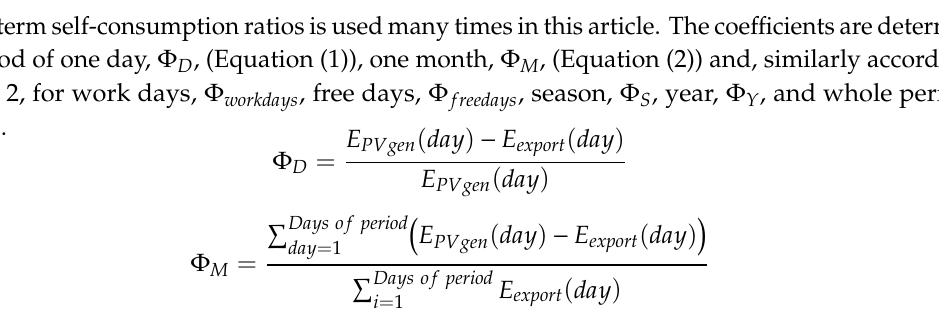
Figure 13. Relative self-consumption as a function of the daily PV generation, indicating the months of the year. Subsequently, the data were grouped into work and free days. Then, a power type trend line was determined for each group. The results in the form of graphs are shown in Figure 14. The calculated average difference in self-consumption between regression curves is about 11% in the energy range from 0.5 kWh to 27 kWh. These are only approximate calculations, but they clearly indicate the impact of the heat accumulation on self-consumption. Cumulative year self-consumption charts (Figure 15) were separately prepared for each year. The indicators on the timeline show the PVS build-up moments. The value of the self-consumption at the end of the year corresponds to its average annual value. A visible drop in value for each subsequent year is due to an increase in the PV power, and is indicated in publications [12,13].